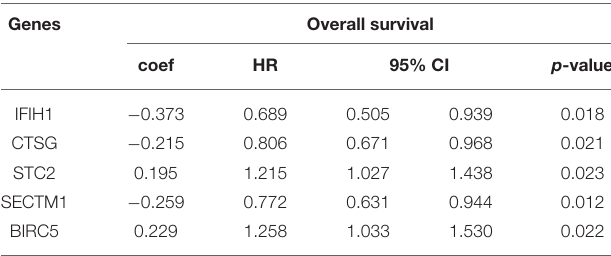
TABLE 1 | The multivariate Cox regression analysis of genes for overall survival.